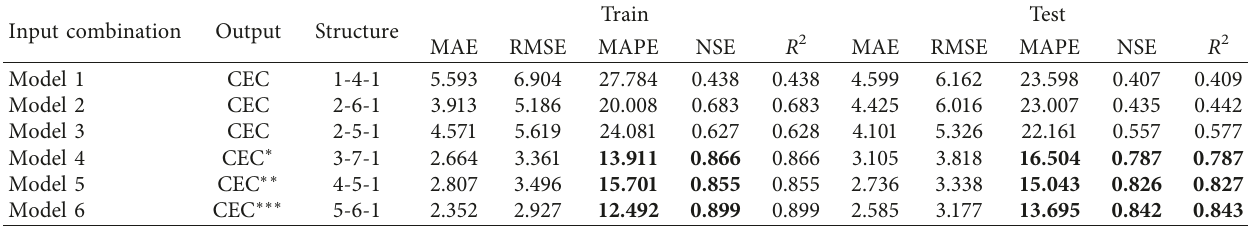
Table 3: The performance criteria of the ANN model for six input